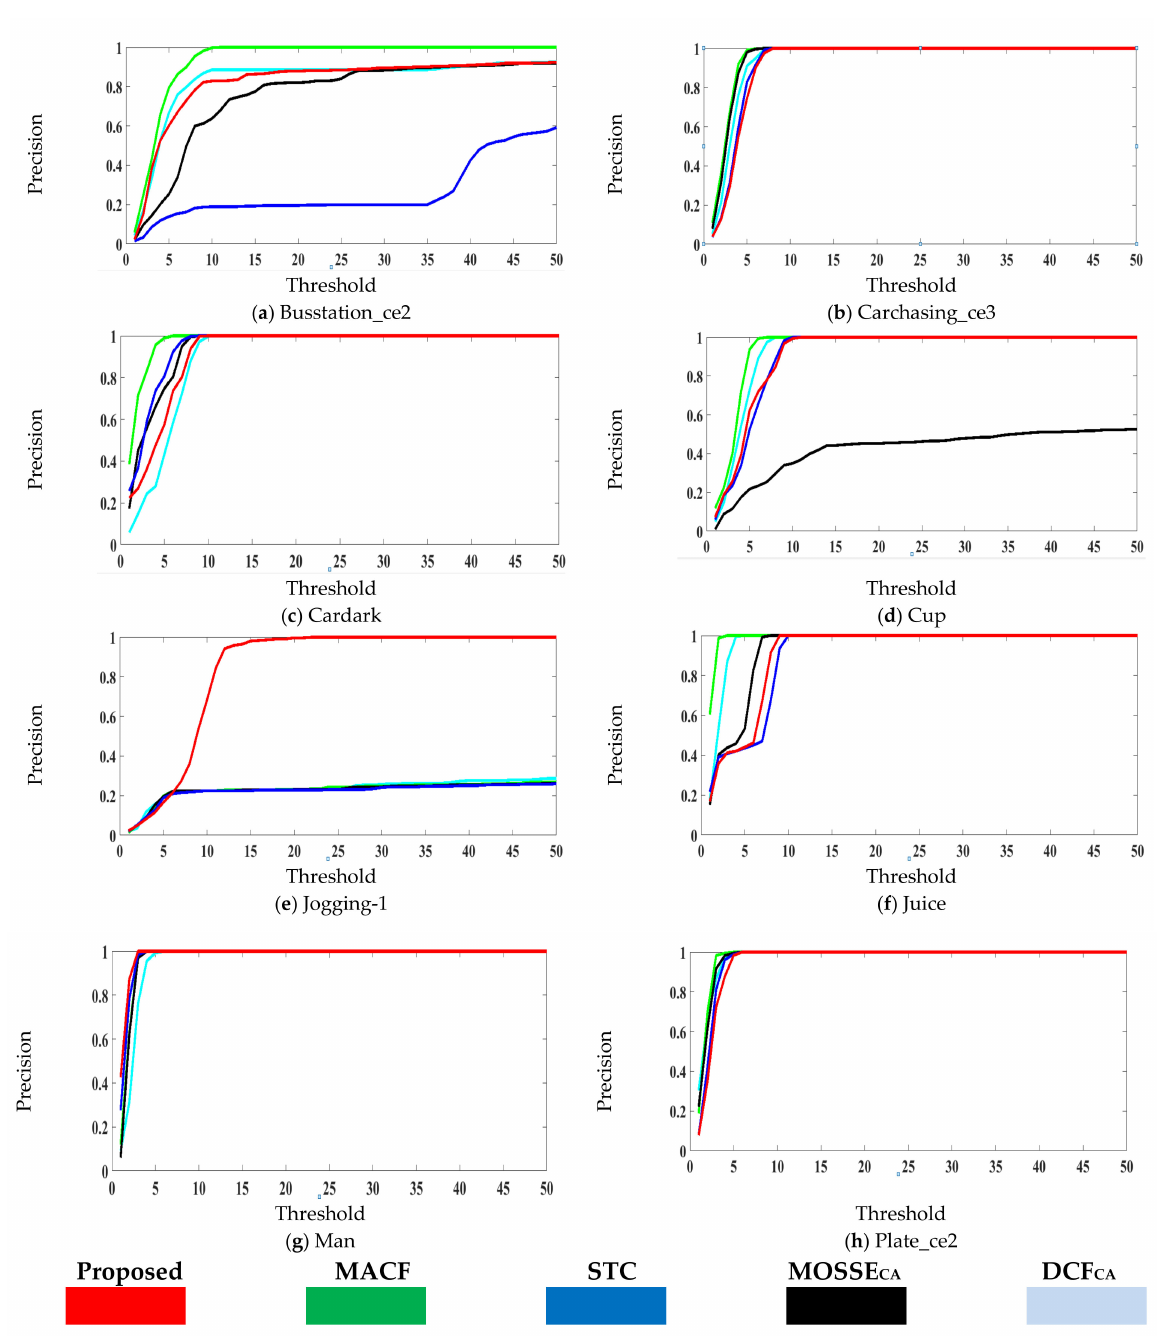
Figure 3. Precision plots comparison of proposed and other state-of-the-art trackers on selected image sequences taken from TC-128, OTB2013 and OTB2015